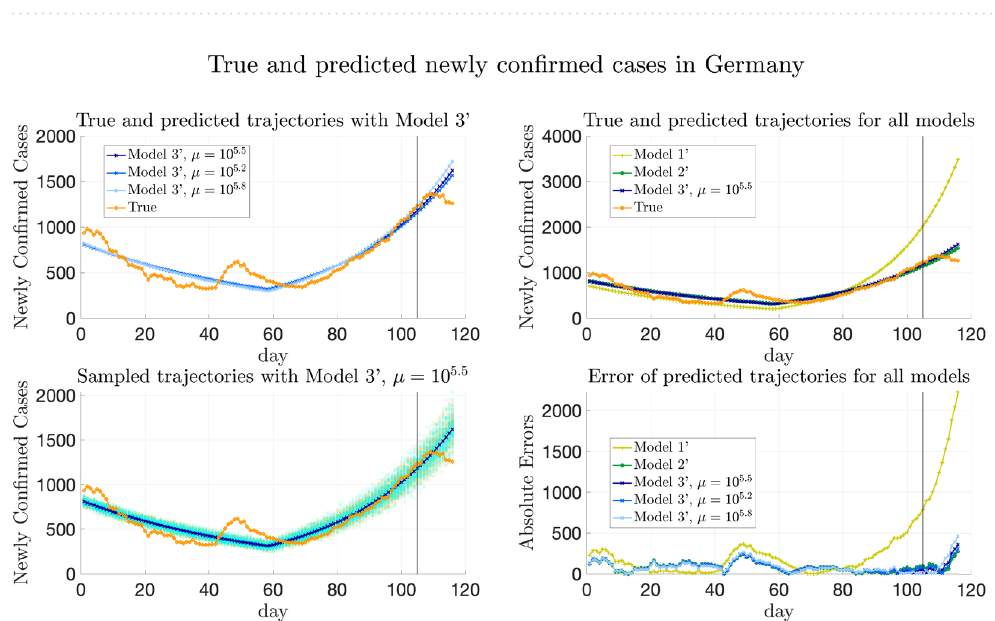
Figure 14. True and fitted trajectories in Germany. The remarks for the lines and scatter plots are the same as those in Fig. 8. The choice of µ = 10 5.2 , 10 5.5 , and 10 5.8 has been explained in Fig.